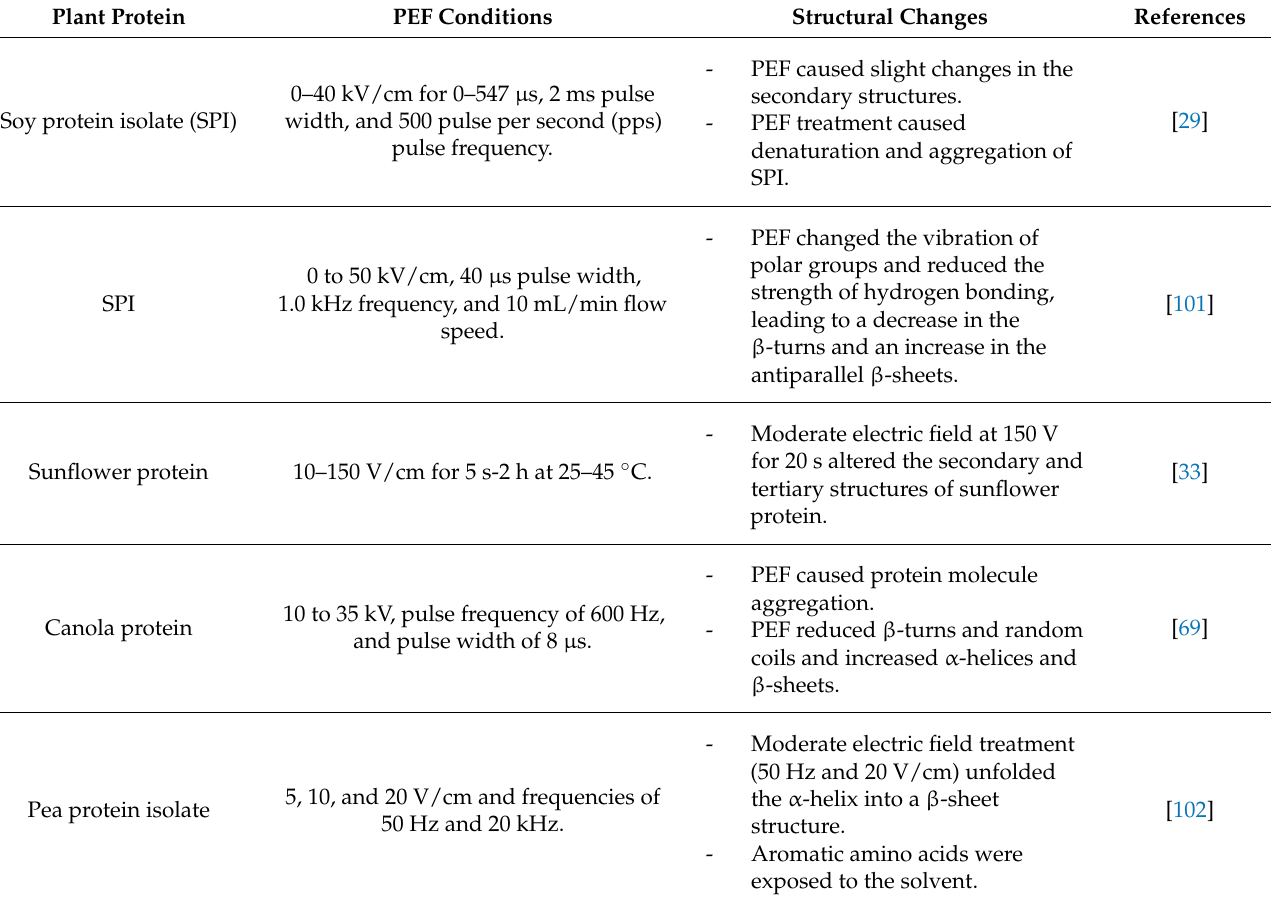
Table 4. Effects of pulsed electric field (PEF) on the structure of plant proteins. Plant Protein